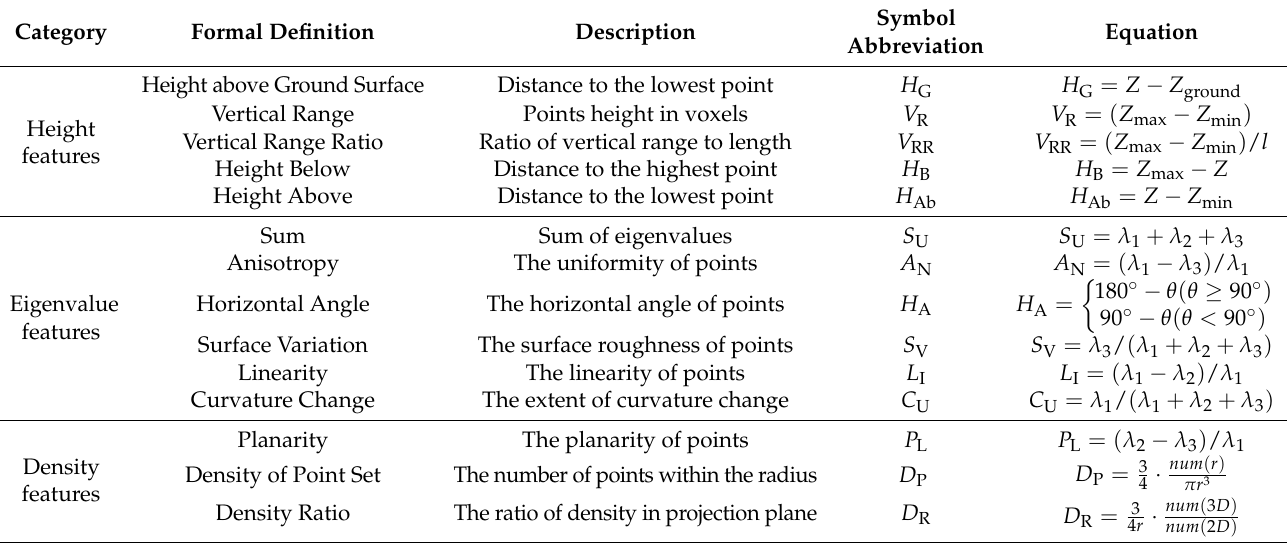
Table 2. The designed features. The first column represents the feature category, the second column represents the feature formal definition name, the third column represents the abbreviation of the feature, and the fourth column is the equation for calculating the